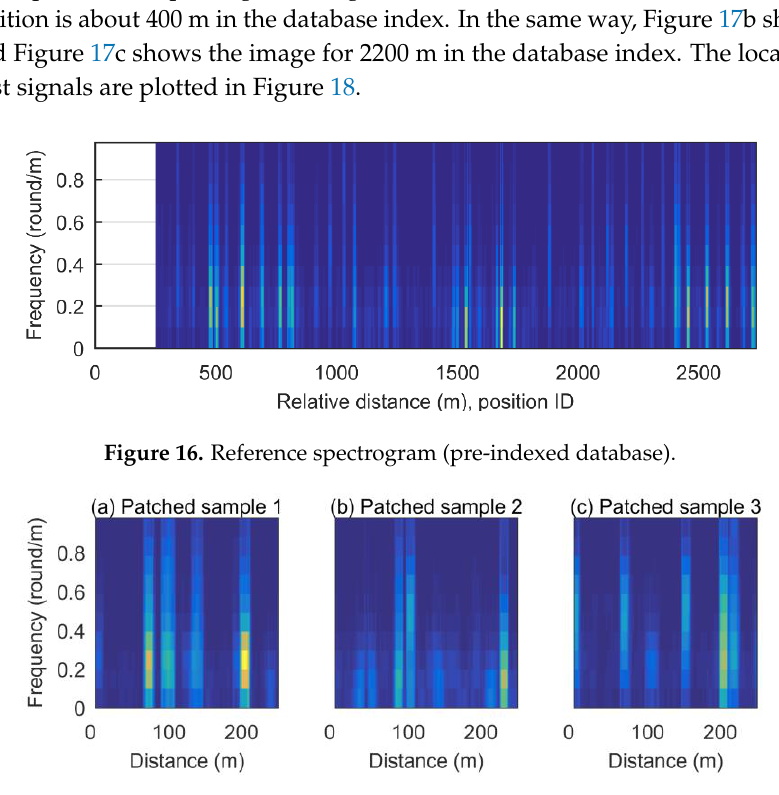
Figure 15. Spectrogram at 750–1000 m: ( a ) Full-sized sedan; ( b ) Compact-sized sedan.